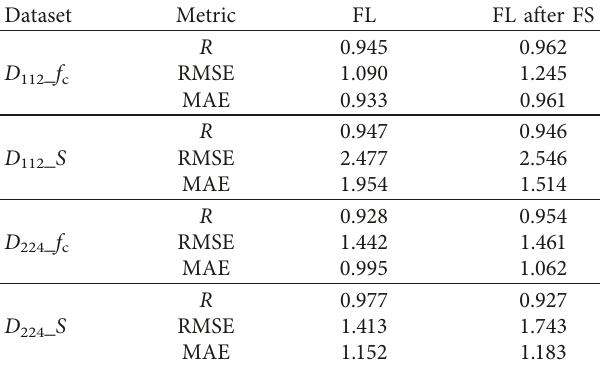
Table 7: The results of the FL regression for the original dataset and selected subset.